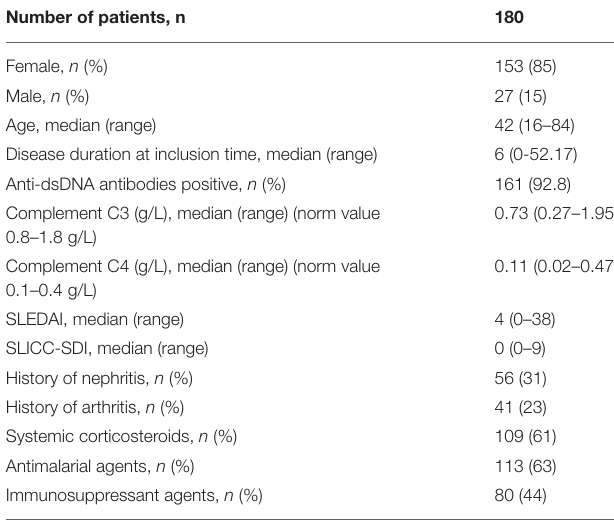
TABLE 1 | Characteristics of 180 patients with systemic lupus erythematosus. Number of patients,